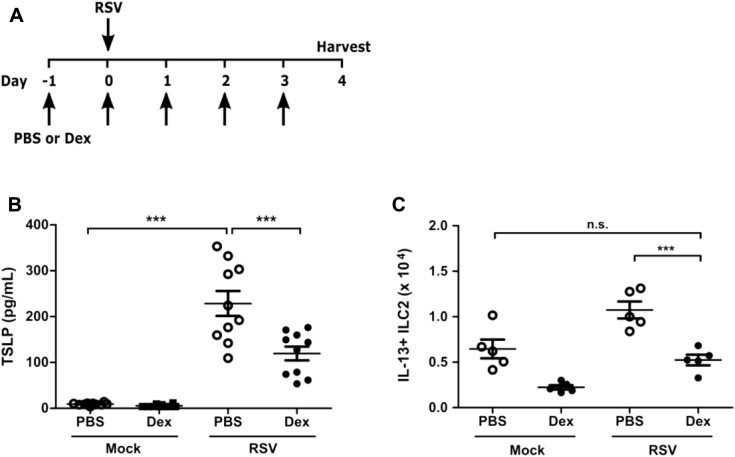
Pretreatment of mice with dexamethasone (Dex) decreases TSLP expression and ILC2 activation. WT mice were treated every 24 hours with 2.5 mg/kg dexamethasone beginning 1 day before infection until harvest. Mice were infected on day 0 with 3 × 106 PFU of RSV strain 01/2-20, and lungs were harvested for flow cytometry at day 4 after infection. A, Protocol for dexamethasone administration. B, ELISA for TSLP in the whole-lung homogenate at 12 hours after infection. C, Total numbers of IL-13+ ILC2s as measured by using flow cytometry at day 4 after infection. Data are plotted as means ± SEMs. For Fig E4, B, n = 10 mice per group combined from 2 independent experiments. For Fig E4, C, n = 5 mice per group representative of 3 similar experiments. ***P < .001, 1-way ANOVA. n.s., Not significant.